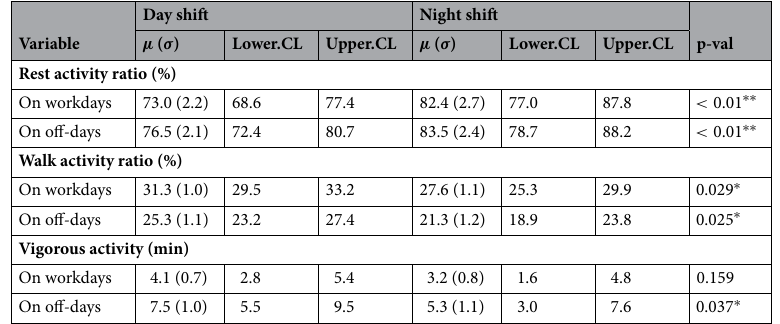
Table 2. Physical activity patterns (in estimated marginal means) between day shift nurses and night shift nurses. Statistical significance of factor shift in the three-way ANOVA test denoted by: p ∗∗ < 0.01 , p ∗ < 0.05 .